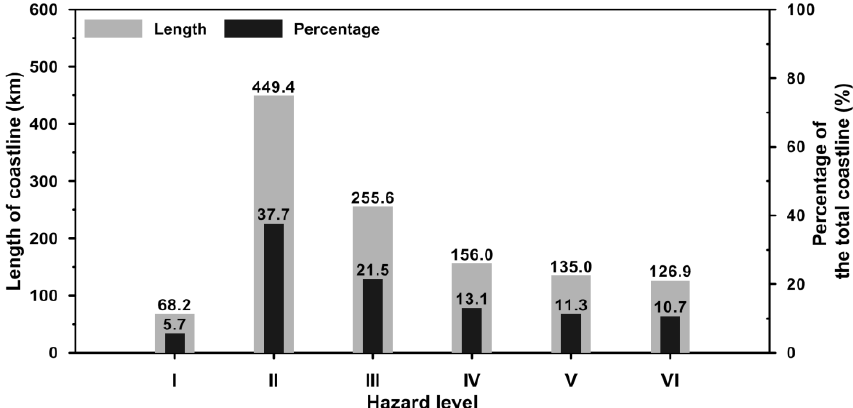
Figure 12. Length of the coastline and percentage of the total coastline corresponding to each hazard level for the comprehensive potential highest storm tide (HST) hazard map.